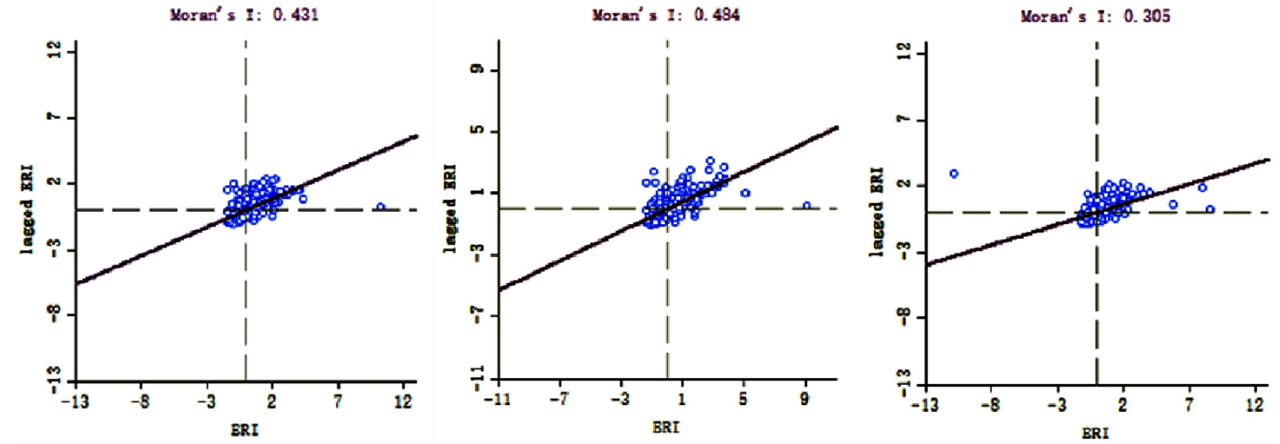
Figure 7. Global spatial autocorrelation of ecological risk in Guangxi.